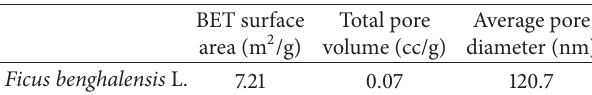
Table 2: Textual characteristics of biosorbent Ficus benghalensis